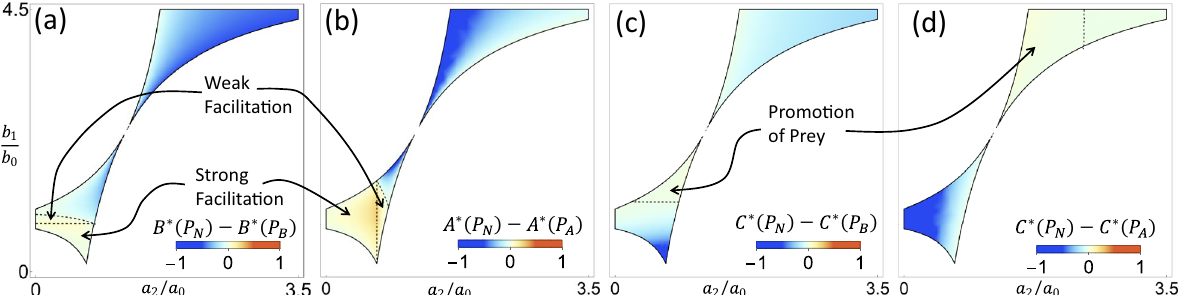
Figure 7. Phase diagrams showing facilitation of predators by their competitor, and promotion of prey by predators. ( a , b ) Parameter regions of strong and weak facilitation, with ( a ) B facilitating A and ( b ) A facilitating B . Color represents the difference between equilibrium populations of each predator in the presence and absence of the other, with X ∗ ( P i ) being the population of species X at equilibrium point P i . ( c , d ) Parameter regions showing promotion of the prey by the addition of a second predator, with ( c ) B promoting C and ( d ) A promoting C . Color represents the difference in population levels of the prey C in the presence of both or only one predator. Parameter values used here are ( a 0 , a 1 , b 0 , b 2 , ρ) = ( 0.25, 0.6, 0.5, 0.6, 0.55 ) , chosen to show significant areas of both types of facilitation and